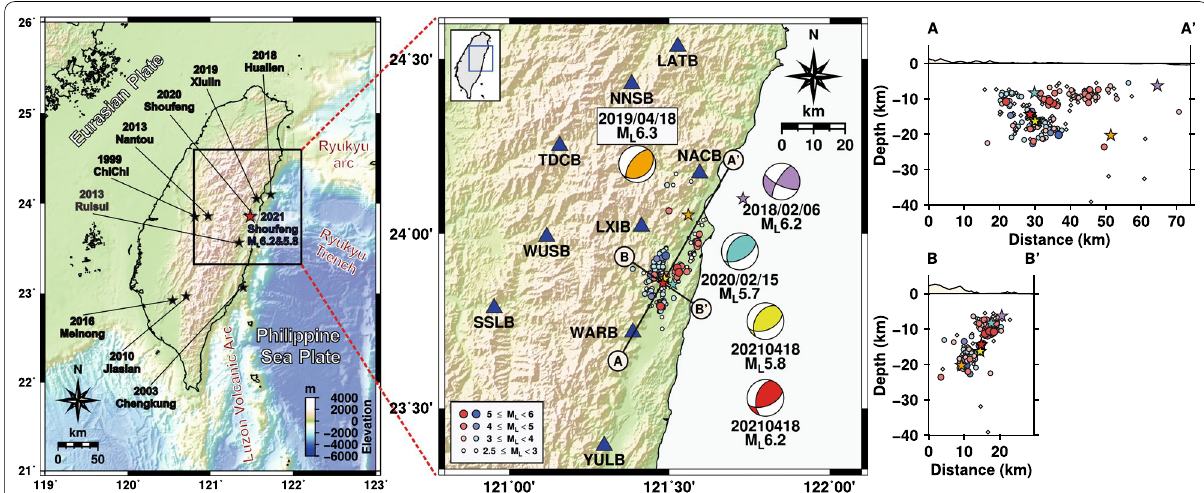
Fig. 1 (Left) Map showing the tectonic setting of the Taiwan region. Several moderate and large earthquakes compared with the Shoufeng earthquake sequence are also plotted. (Middle) Seismicity in the Shoufeng region, Hualien County, Taiwan. The red‑tone circles denote aftershocks occurring before June 8, 2021; the blue‑tone circles show aftershocks occurring after June 8, 2021. The stars indicate the two 2021 Shoufeng earthquakes and several moderate‑sized earthquakes occurring around the source area of the 2021 events. Also included are the focal mechanisms reported from the BATS (IES 1996). (Right) AA ′ and BB ′ profiles reveal that these events are distributed at different depths (< 25 km). The cross‑section of these events along line BB ′ shows a west‑dipping plane, which might be the fault plane of the two 2021